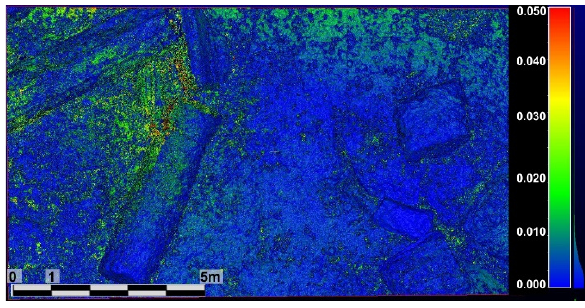
Figure 7. Cloud G9a to reference cloud deviation [m].